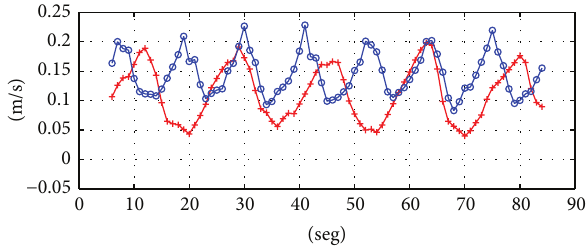
Figure 10: Comparing measurement data (+) and simulated data ( ∘ ) of the velocity component 𝑈 on the viewer 𝑉 1 obtained using the ml-04 model. Table 2: Average values in the frequency domain. Model